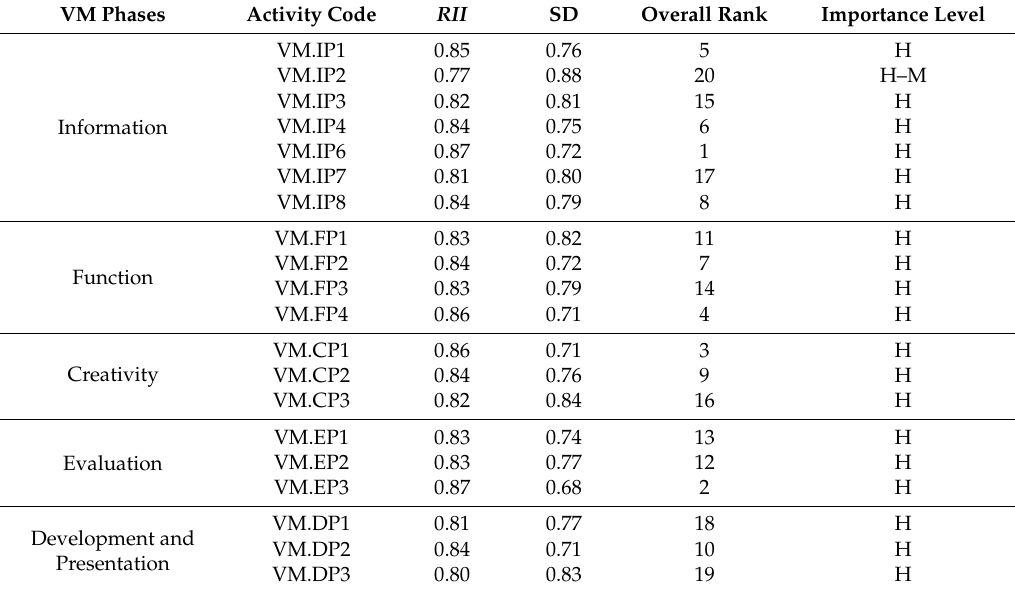
Table 2. Relative importance of VM activities in residential building